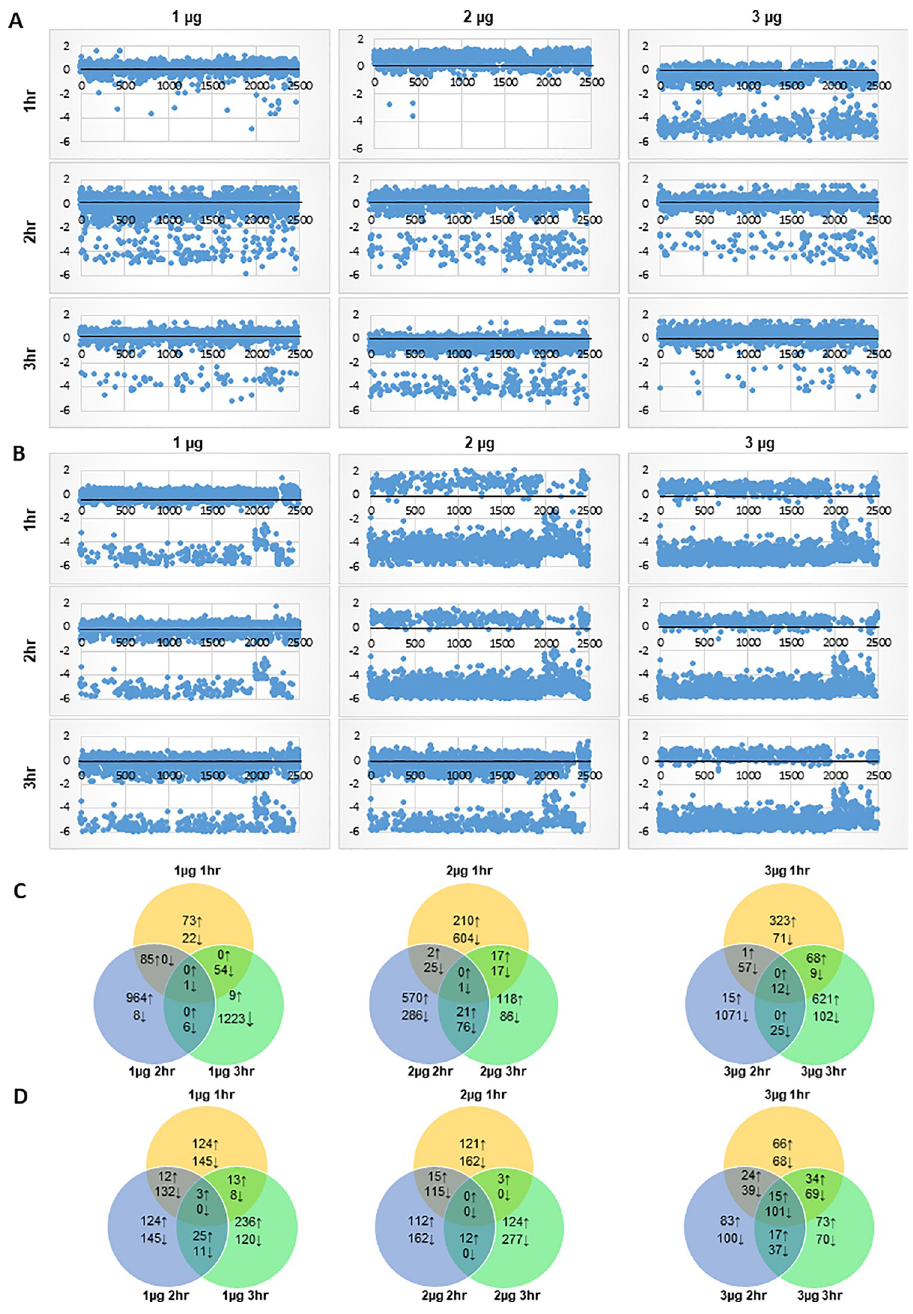
Fig 2. Dynamic changes in the transcriptomes of E . coli O157:H7 and L . monocytogenes in response to different doses of O 3 . (A and B) Scatter plots of the Propensity Scores (PS) for each transcriptome library in E . coli O157:H7 (A) and L . monocytogenes (B). (C and D) Total numbers of E . coli (C) and L . monocytogenes (D) genes that were differentially expressed in response to 1 μ g, 2 μ g, and 3 μ g of O 3 per gram of ripe tomato after 1 hr, 2 hr, and 3 hr exposure at each dose. Total numbers of upregulated ( " ) and downregulated ( # ) genes that were either treatment- specific or shared between treatments are displayed in the Venn